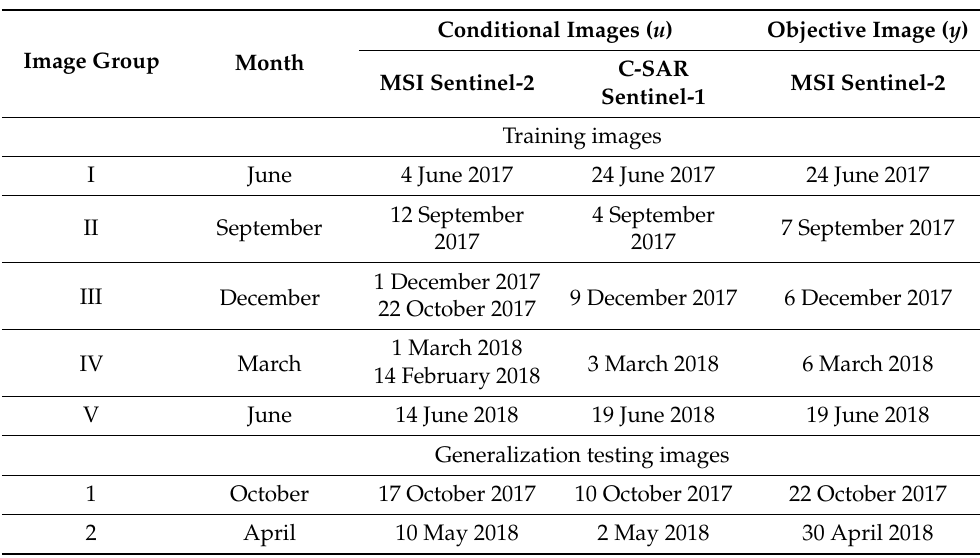
Table 3. Image date for the conditional and objective images.